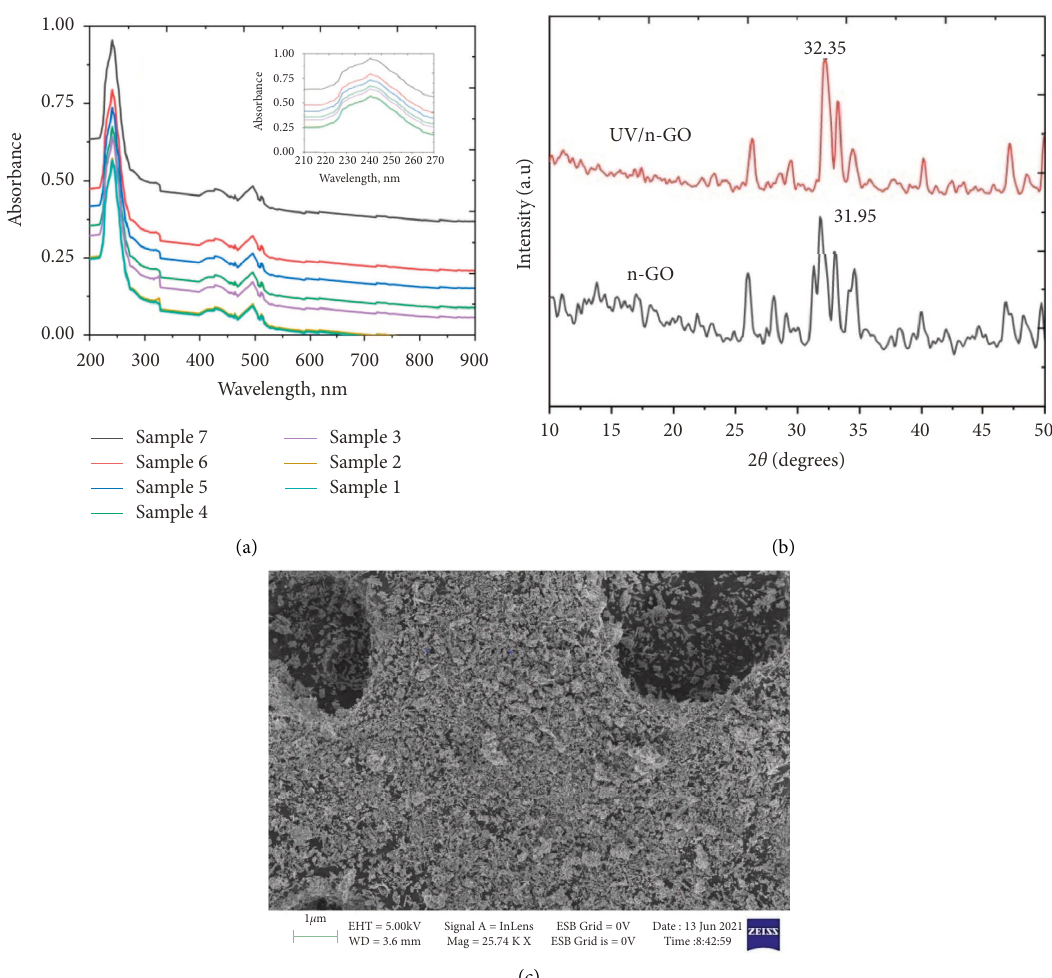
Figure 1: (a) UV analysis of UV/n-GO; (b) XRD of n-GO and UV/n-GO; (c) SEM image of